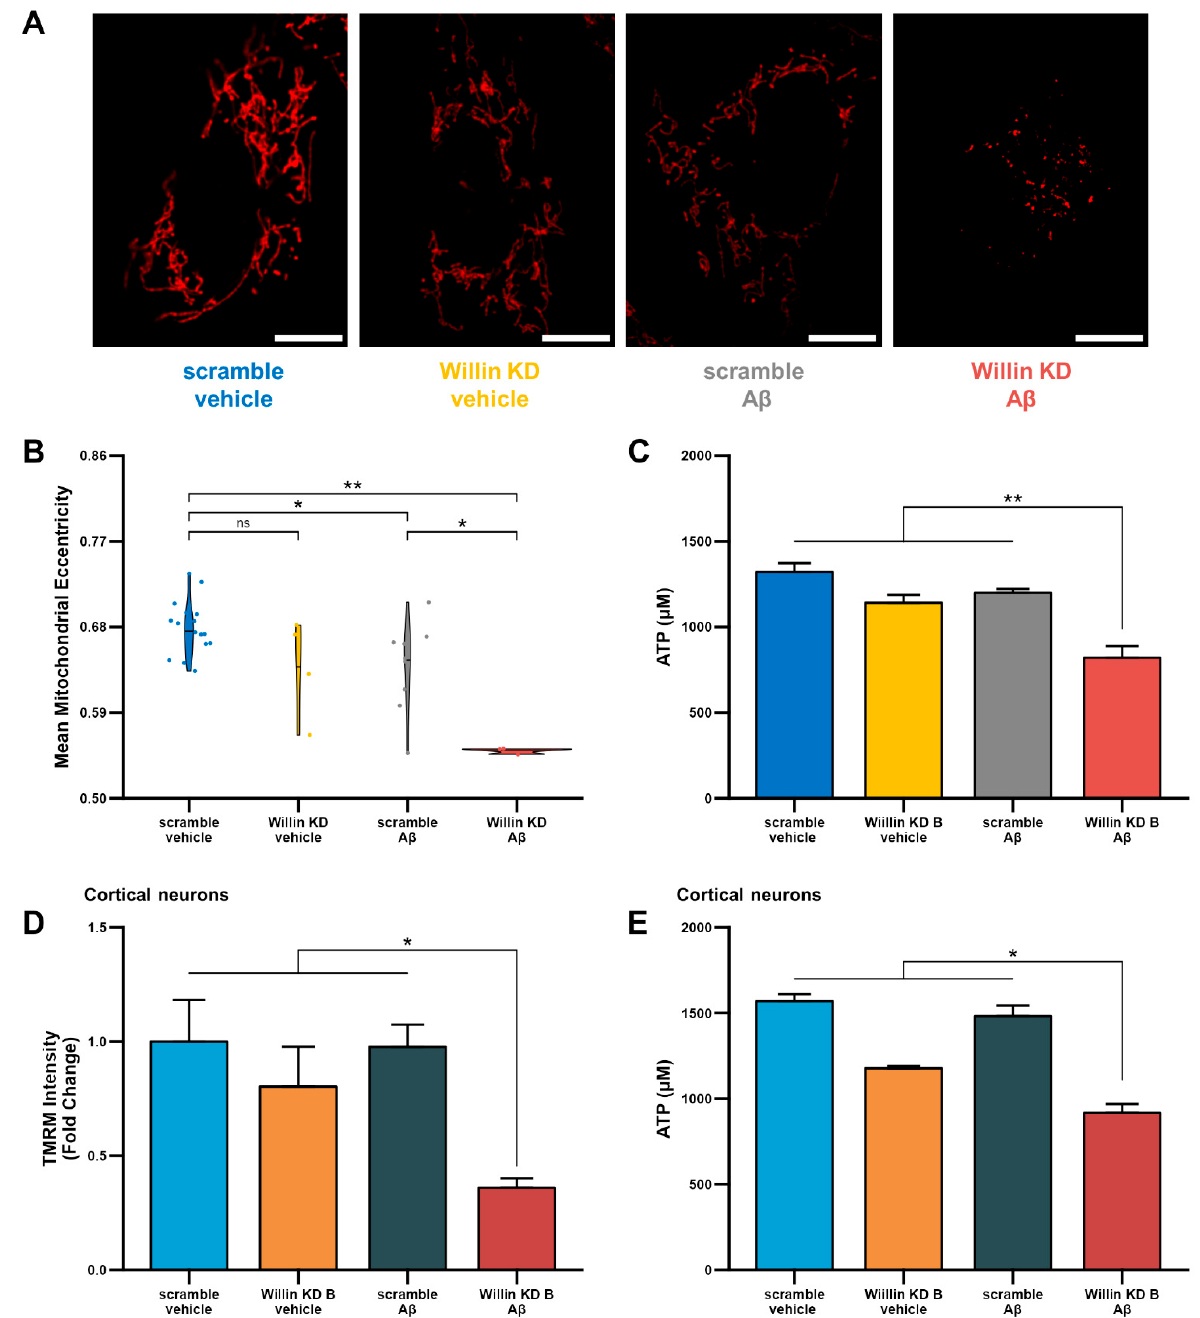
Figure 6. Downregulation of Willin/FRMD6 triggers A β -induced mitochondrial dysfunction in HT-22 cells and primary mouse neurons. ( A , B ) HT-22 cells were exposed to A β (5 μ M) for 48 h prior to labeling with TMRM for visualization of mitochondria morphology. ( A ) Representative images of TMRM staining. Scale bar = 10 μ m. ( B ) Quantitative measurement of mitochondrial eccentricity using MitoSegNet. n = 3–16 FOV per group with 2-28 cells per FOV. Dots represent means per FOV. * p < 0.05. ** p < 0.01. ns = not significant. ( C ) ATP levels in HT-22 cells were measured by luciferase assay following exposure to A β (10 μ M) for 24 h. n = 3 per group. ** p <